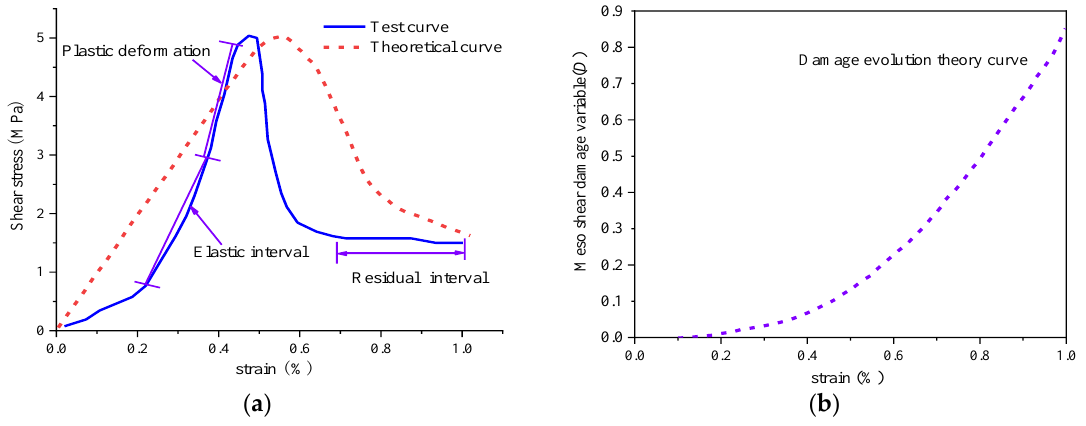
Figure 3. Complete rock specimen shear damage model evolution curve for the ( a ) comparison between the theoretical and experimental stress–strain and ( b ) meso shear damage theory [45,48,49]. According to Figure 3a, the theoretical damage curve based on the Weibull distribution is basically consistent with the trend of the rock shear stress–strain curve before failure, and the peak failure strength is basically equal. The peak shear strength derived from the theory is almost consistent with the experimental results, while the strain corresponding to the peak strength is slightly larger than that in the theoretical model. In this paper, the meso-shear damage model of the intact rock specimen is simplified, and the influence of the initial tiny cracks and pores on the curve is ignored. Figure 3b shows that the mesoscopic damage is still at a low level before the shear peak strain, and the theoretical stress–strain curve presents an approximately linear variation. When the curve passed the peak strain point, the shear damage variable D increased sharply, while the stress–strain curve tended to moderate, and the shear stress gradually decreased, indicating that the shear rock entered the yield stage in this stage. Therefore, the meso-damage variable corresponding to the peak strain at the peak shear point can be regarded as the benchmark criterion for reaching the critical point of damage and failure in the shear process of